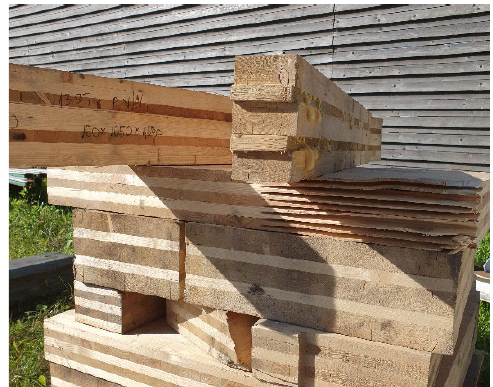
Fig. 1. Cross laminated timber non-reusable